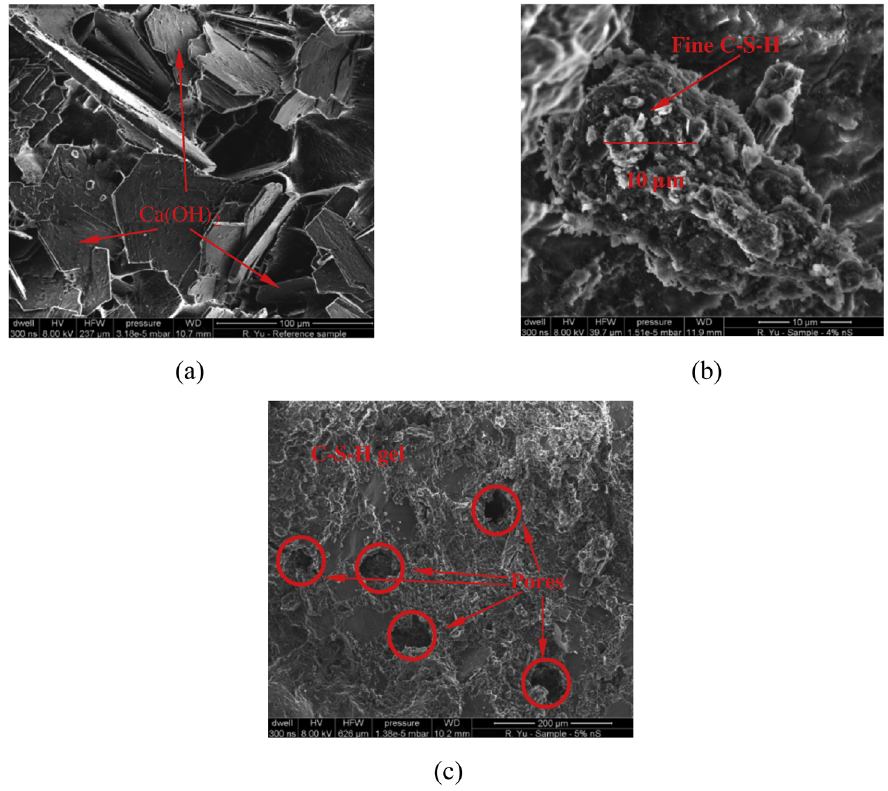
Figure 2: SEM images of di ff erent content of nano - silica replacement cement in UHPC: ( a ) 0.0%; ( b ) 4.0%; and ( c ) 5.0% [ 38 ]